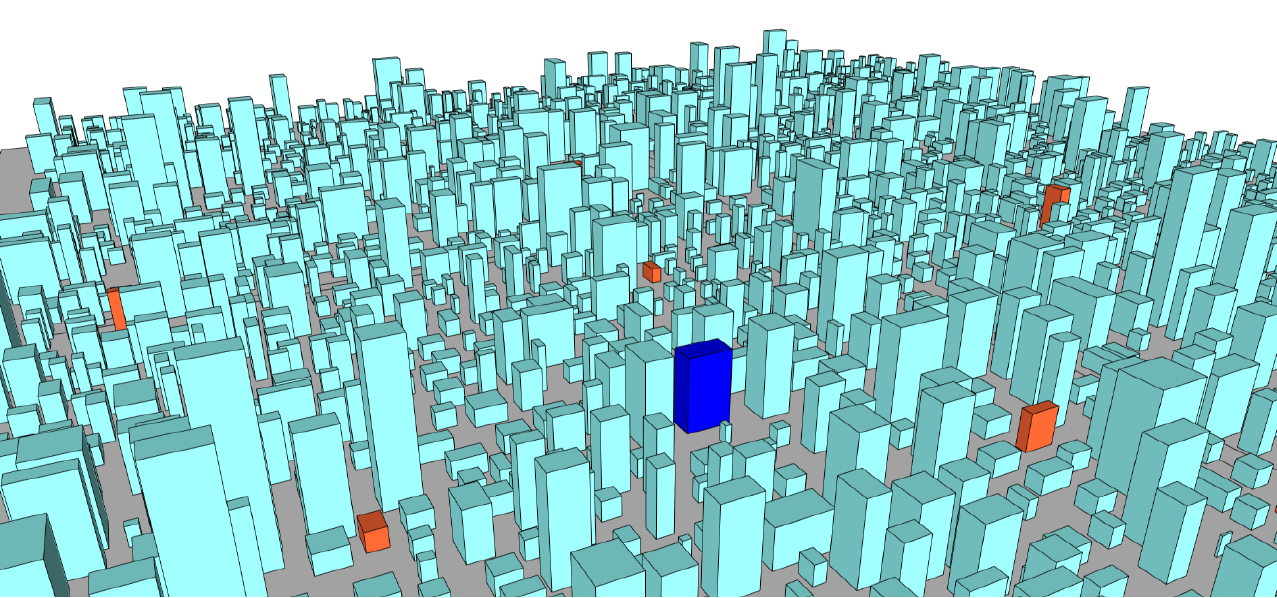
Figure 5. Location of new franchise and other